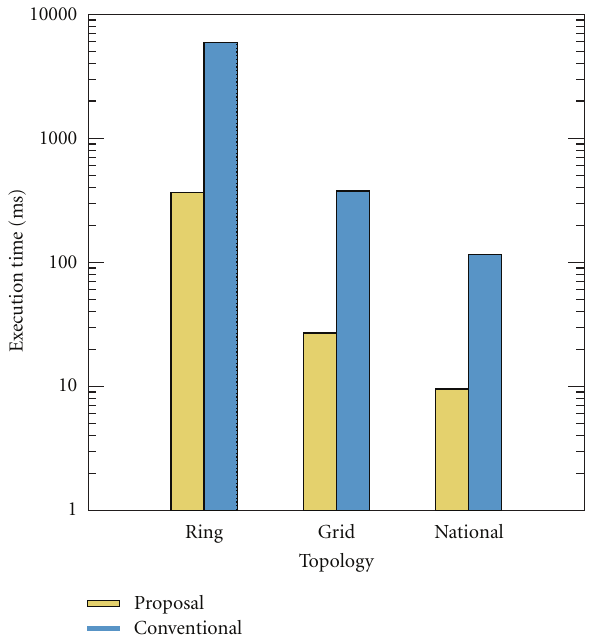
Figure 11: Execution time of the proposed algorithm versus the number of hops on the ring and grid network